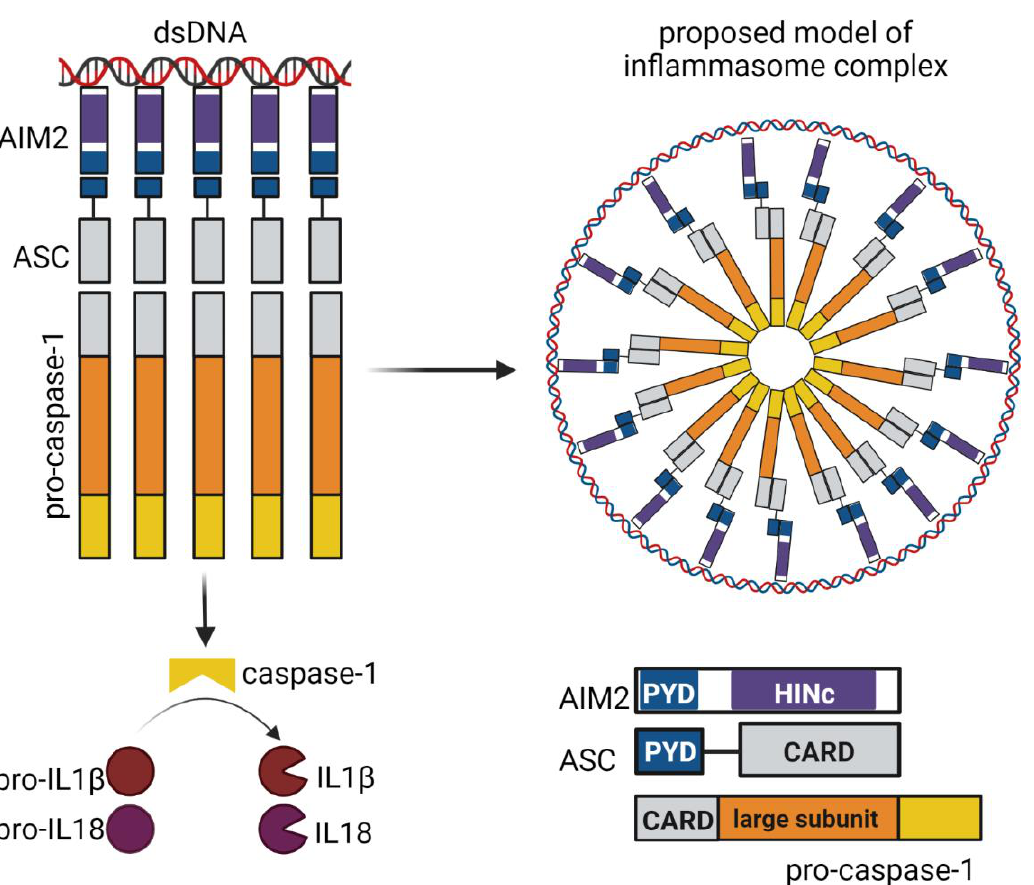
Figure 4. AIM2 inflammasome signaling pathway activation upon binding to DNA. AIM2 recognizes dsDNA and leads to AIM2 polymerization, then the ASC protein is recruited via PYD domains and forms filaments (nucleates). Caspase 1 binds to the dsDNA–AIM2–ASC complexes and is activated, leading to the maturation of IL-1 β and IL-18. Created with BioRender.com.